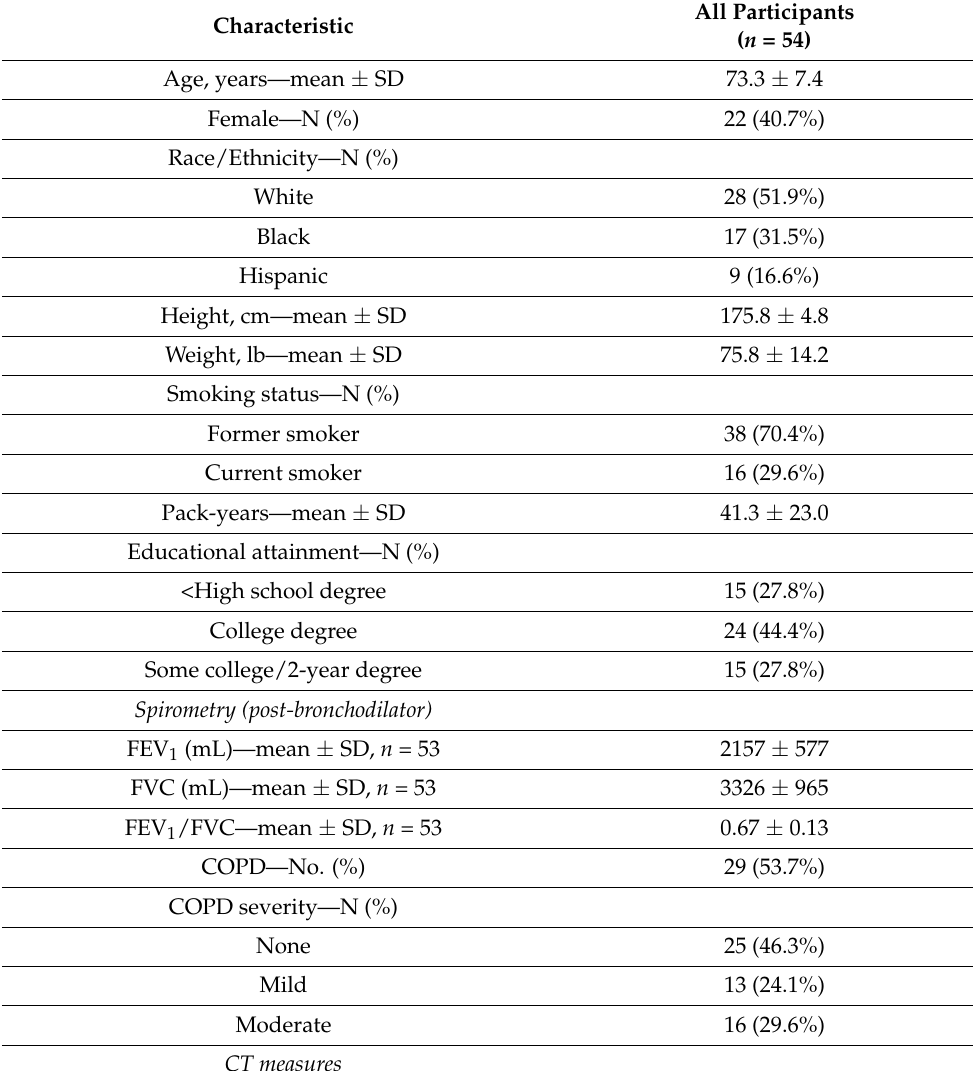
Table 1. Characteristics of the study